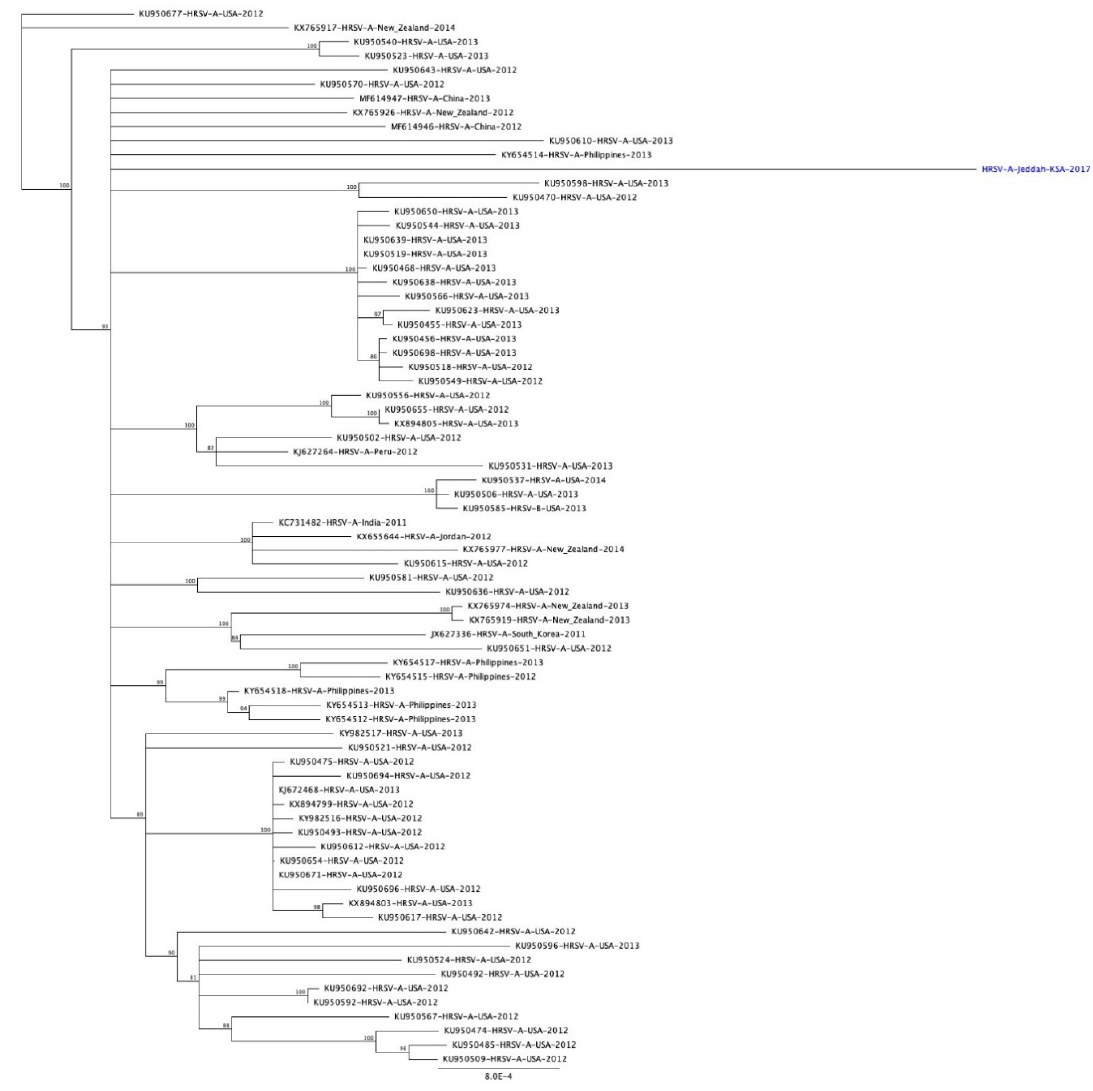
Figure 6. Phylogenetic analysis of full genome RSV group A in Jeddah, Saudi Arabia (2017). Saudi sequences in this study are labeled with ( ● ) and reference strains are named as accession number-country-year of isolation. A phylogenetic tree was constructed the using neighbor-joining method after being aligned with the CLUSTALW using MEGA 7.